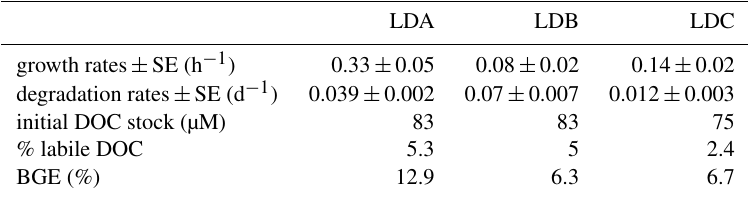
Table 5. Results of biodegradation experiments. Growth rates determined from BP data, degradation rates computed from DOC data and BGE computed from Eq.